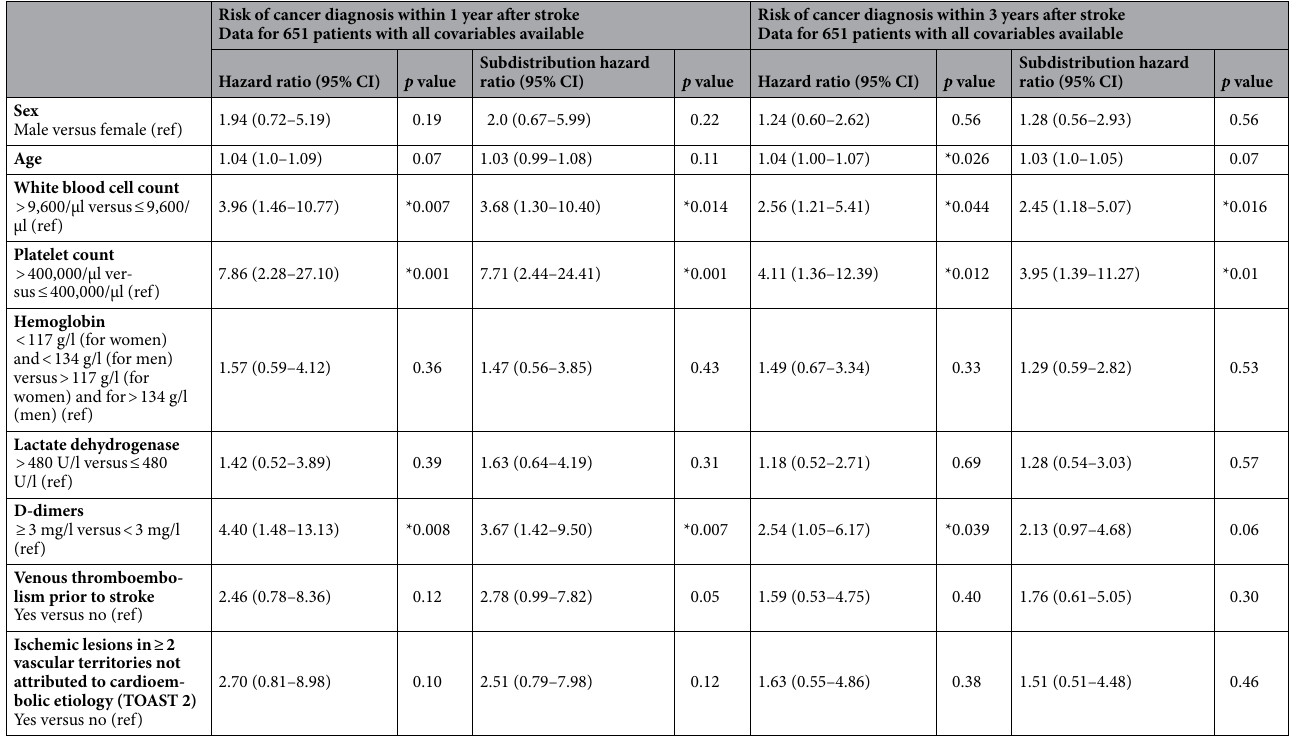
Table 3. Risk of cancer diagnosis after stroke without and with consideration of death as competing risk in multivariable